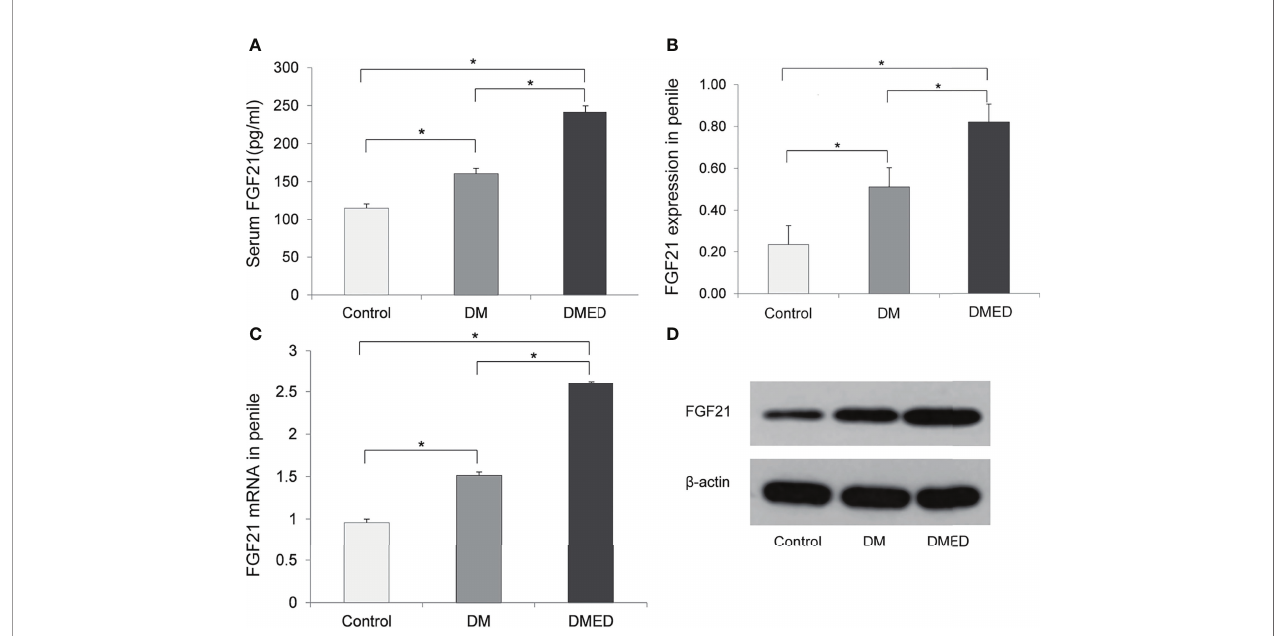
FIGURE 3 | The expression of FGF21 and FGF21 mRNA in rat model. (A) The level of serum FGF21; (B) The relative level of FGF21 protein in penile samples; (C) The relative level of FGF21 mRNA in penile samples; (D) The representative result of western blotting assay of FGF21 in penile samples. The data shown in the graphs represent the mean ± SD, * P <